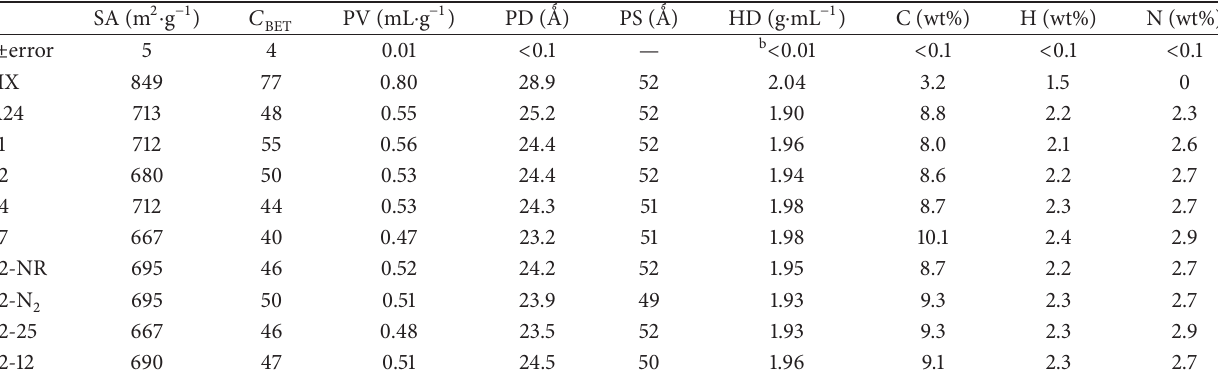
Table 1: Basic characterisation data.